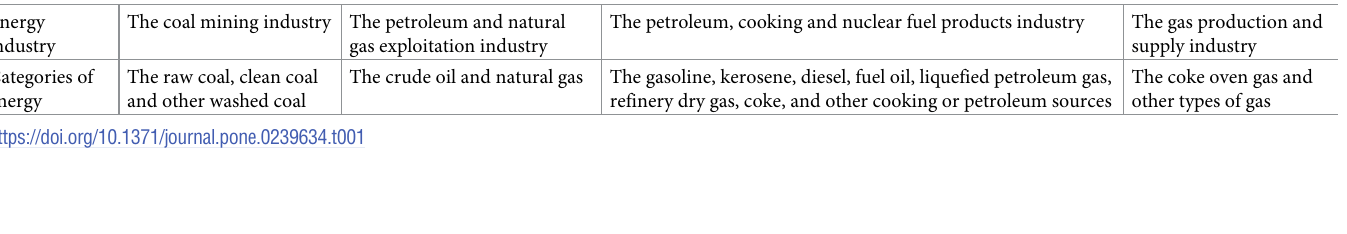
Table 1. The relationship between these four energy sectors and energy